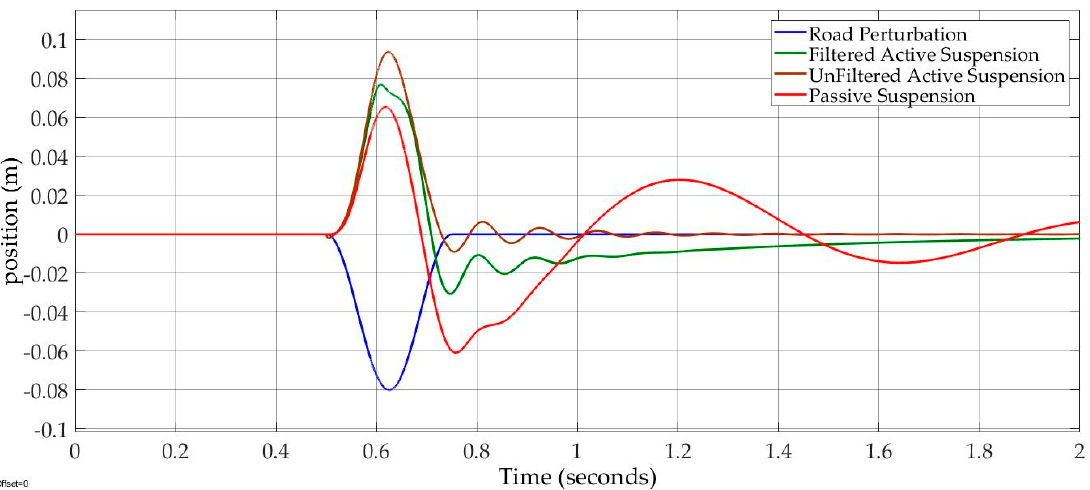
Figure 17. Suspension travel of Case 4.